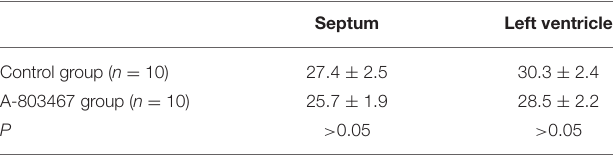
TABLE 1 | Percentage of ischemic myocardial mass